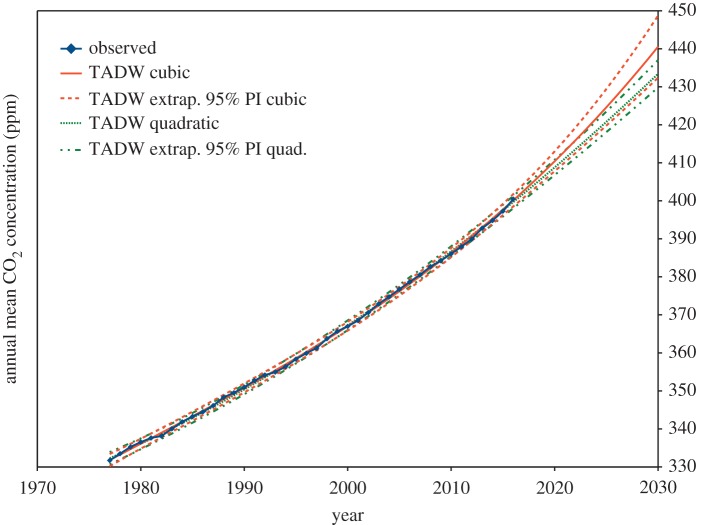
Annual means of background atmospheric carbon dioxide, Cape Grim, Tasmania. Linear and quadratic GLS models, using the new TADW estimate of ρ from (3.1), are plotted. Prediction intervals are constructed with the extrapolated standard errors from (3.4). The quadratic model prediction interval from 2016 to 2030 overlaps the interval for the cubic model, but as the t3 coefficient in the cubic model is just statistically significant (textrap = 2.23, Pr(>|t|) = 0.032), the wider prediction interval of the cubic model may be more realistic.